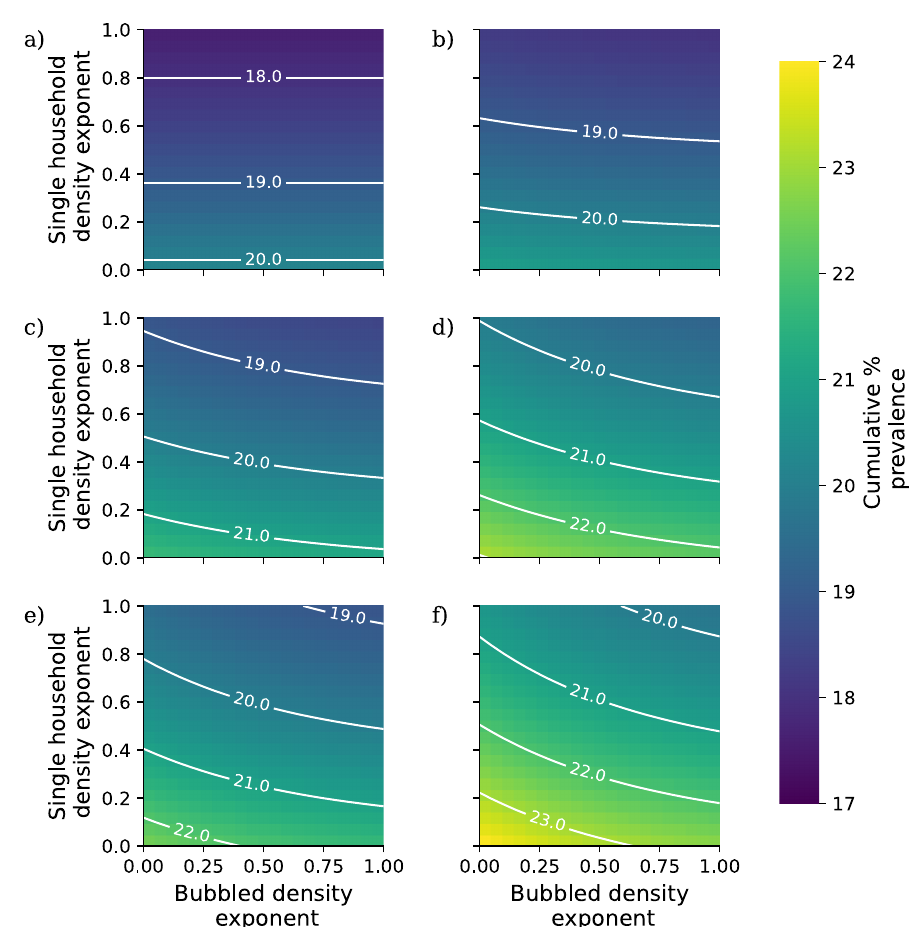
Fig 6. Cumulative prevalence between December 1st 2020 and February 1st 2021 as a function of density exponents in single households and in bubbled households under the following relaxation policies: a) no relaxation; b) two- household bubbles on December 25th; c) two-household bubbles on December 25th and again on December 26th; d) three-household bubbles from December 25th to December 26th; e) two-household bubbles on December 25th, again on December 26th, and again on December 31st; f) three-household bubbles from December 25th to December 26th and two-household bubbles on December 31st.